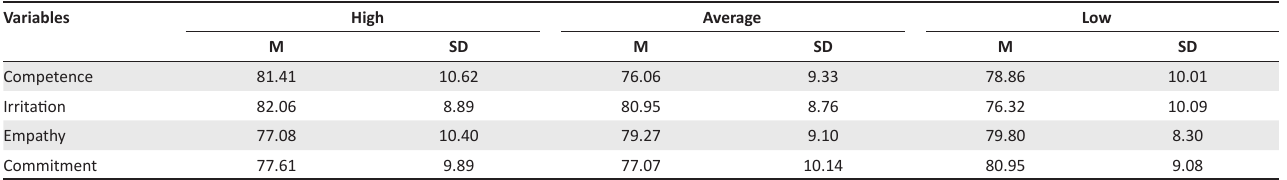
TABLE 5: Attitudes toward suicidal behaviour measured with the validated Attitudes Toward Suicide Scale according to self-rated competence, commitment, empathy and irritation toward patients’ suicidal behaviour.